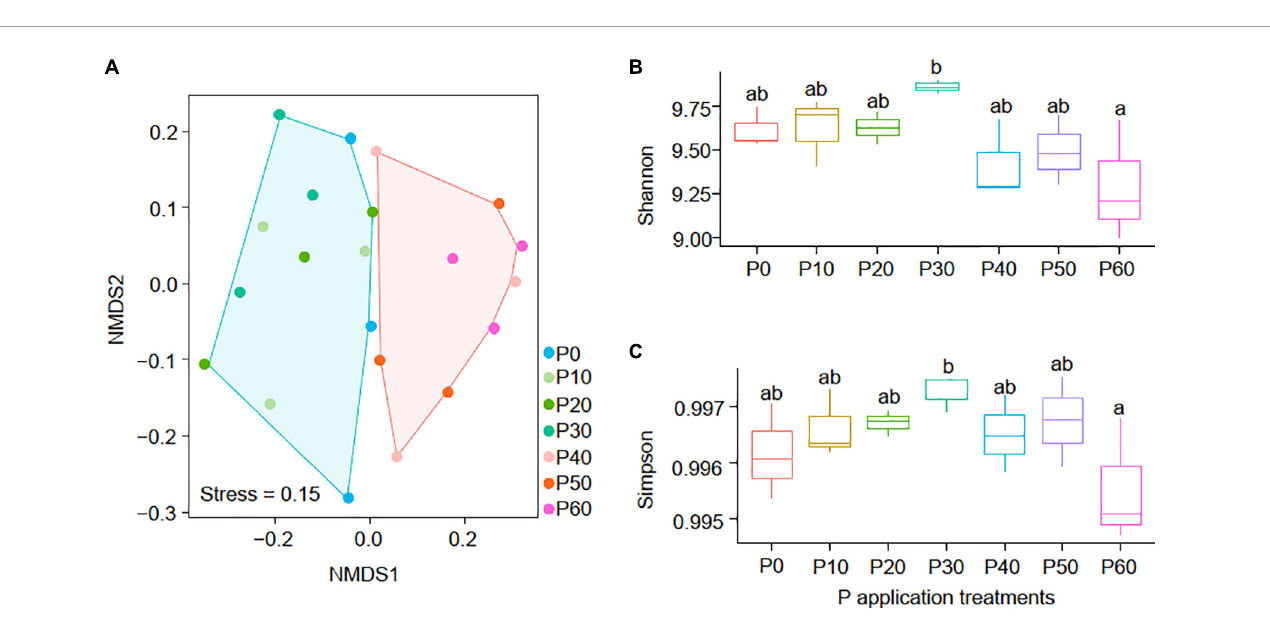
FIGURE4 The NMDS of the phoD-harboring microbial composition (A) in all samples and the variations of the phoD-harboring microbial Shannon (B) and Simpson (C) diversity among the seven application